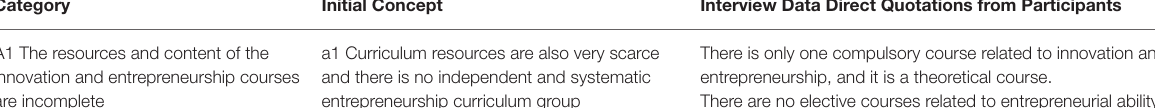
TABLE 1 | Examples of open